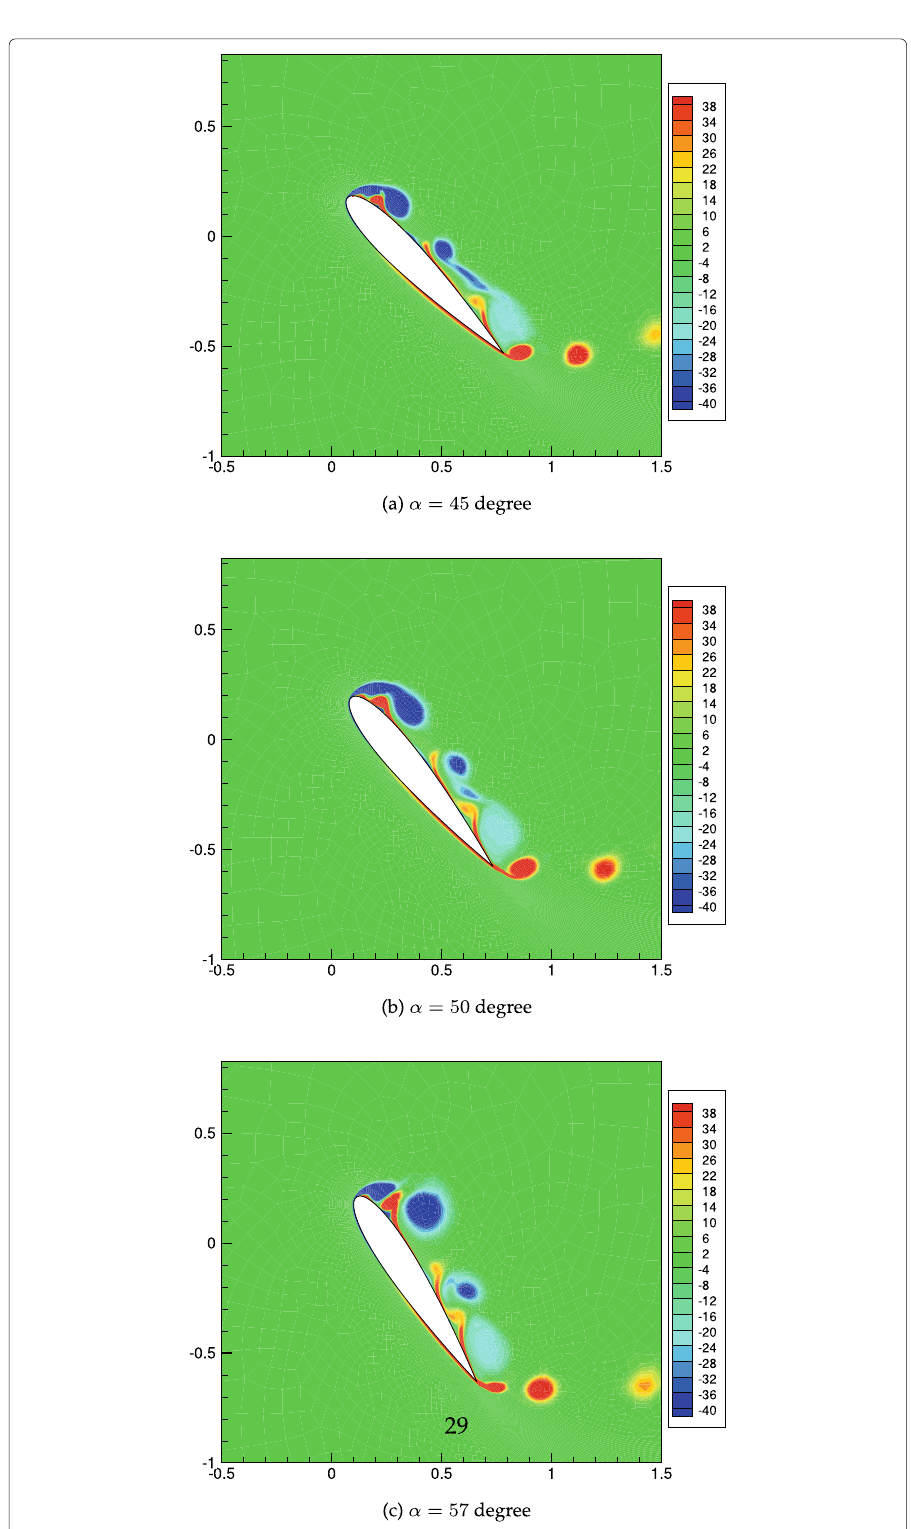
Fig. 13 Normalized vorticity contour at three different angles of attack for the pitching NACA0015